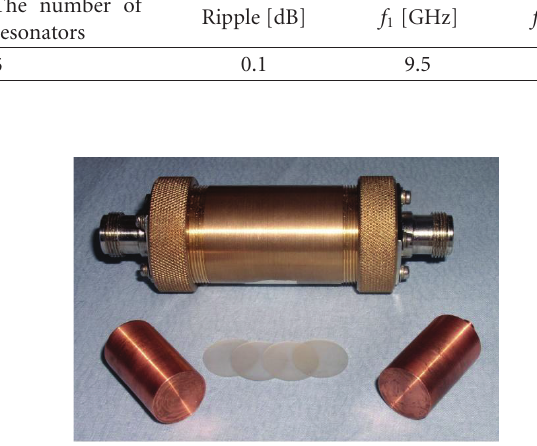
Figure 7: General view of the filter prototype with the single slot.